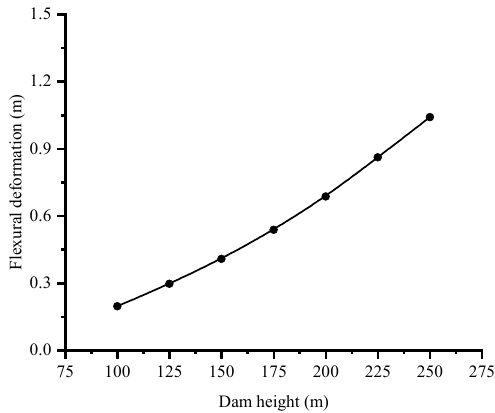
Figure 20. Relationship between flexural deformation maximum of SACC and dam height.